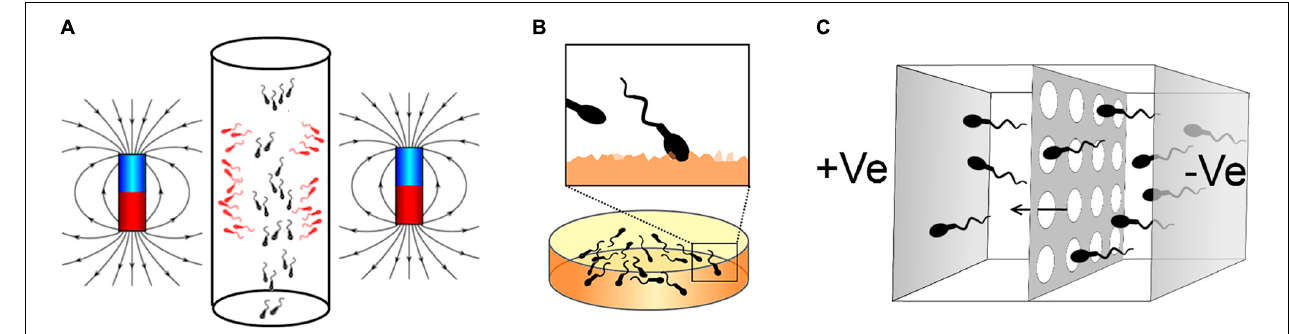
FIGURE 2 | Methods for sperm selection based on membrane characteristics. (A) Example of Annexin V magnetic activated cell sorting (AV-MACS): Apoptotic spermatozoa (red in the figure) are bound to magnetic nanoparticles coated with Annexin V and affinity to the externalized phosphatidylserine in this sperm population. Semen is then passed through a column with magnetos on the side, thus apoptotic spermatozoa are retained and non-apoptotic are washed out for downstream applications. (B) Example of method for sperm selection based on hyaluronic acid-binding. Spermatozoa are placed on a dish coated with hyaluronic acid (HA, orange in the figure). Matured spermatozoa bind to the surface due to their interaction with the HA. These spermatozoa can be then recovered for ICSI using a micromanipulation system. (C) Example of sperm selection by the Z-method developed by Ainsworth et al. (2005): Spermatozoa are placed in a well isolated from another adjacent well by a porous membrane and filled with a medium free of cells. An electric field is then applied with the anode in the well free of cells and the cathode in the well containing the sperm suspension. Due to the negative charge of the sperm membrane, spermatozoa migrate towards the compartment free of cells passing through the porous membrane. Spermatozoa can be then collected for downstream